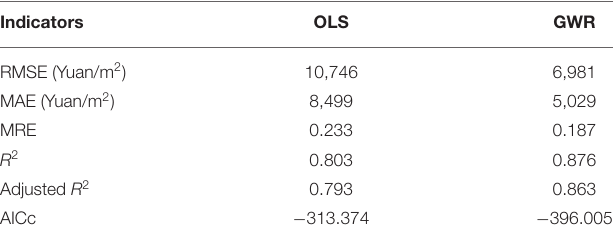
TABLE 5 | OLS and GWR comparison